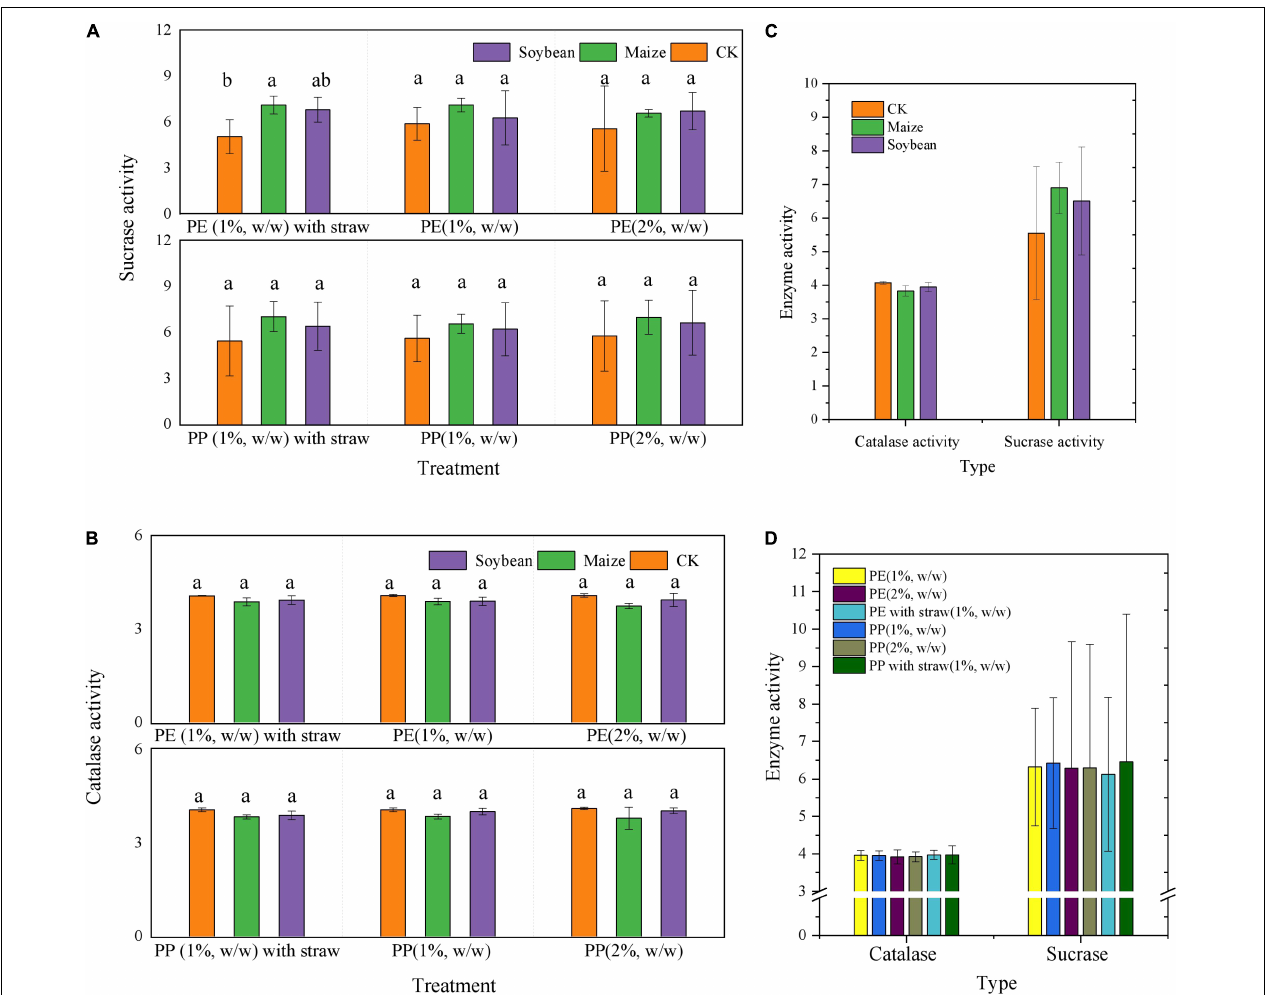
FIGURE 6 | Enzyme activity of sucrase and catalase differed in the soybean and maize growth treatments, PE, PP addition, and with and without straw addition. (A) Sucrase, (B) catalase, and (C) enzyme activity with different crop growth. (D) Enzyme activity with different contents and types of microplastics and straw addition. CK was the control treatment without crop growth. Columns followed by the same letter were not significantly different based on a least significant difference (LSD) multiple range test ( p < 0.05).